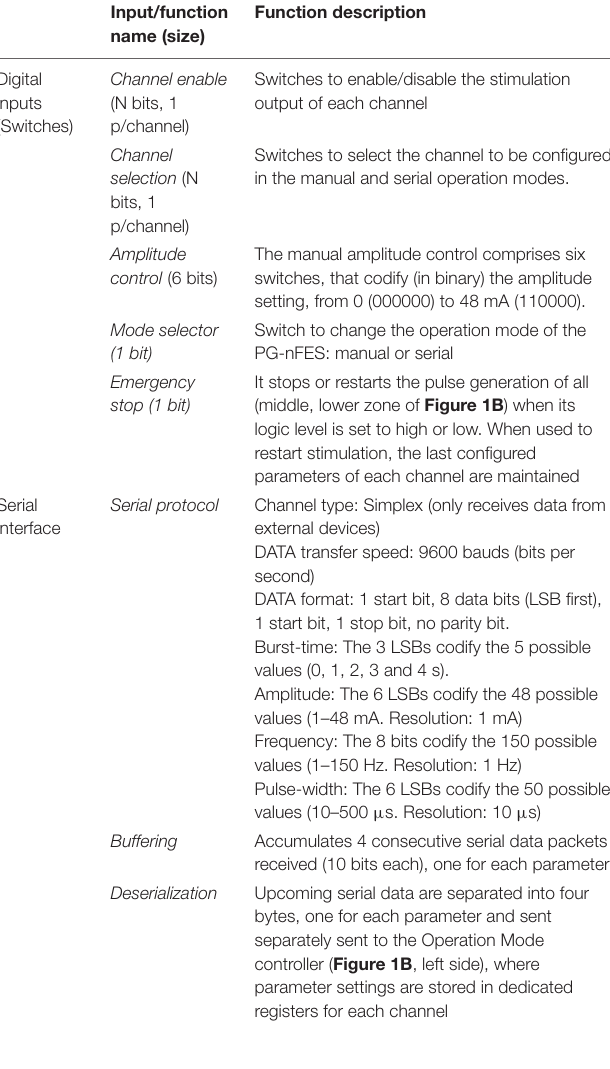
TABLE 2 | Functions of digital inputs and the serial interface of the